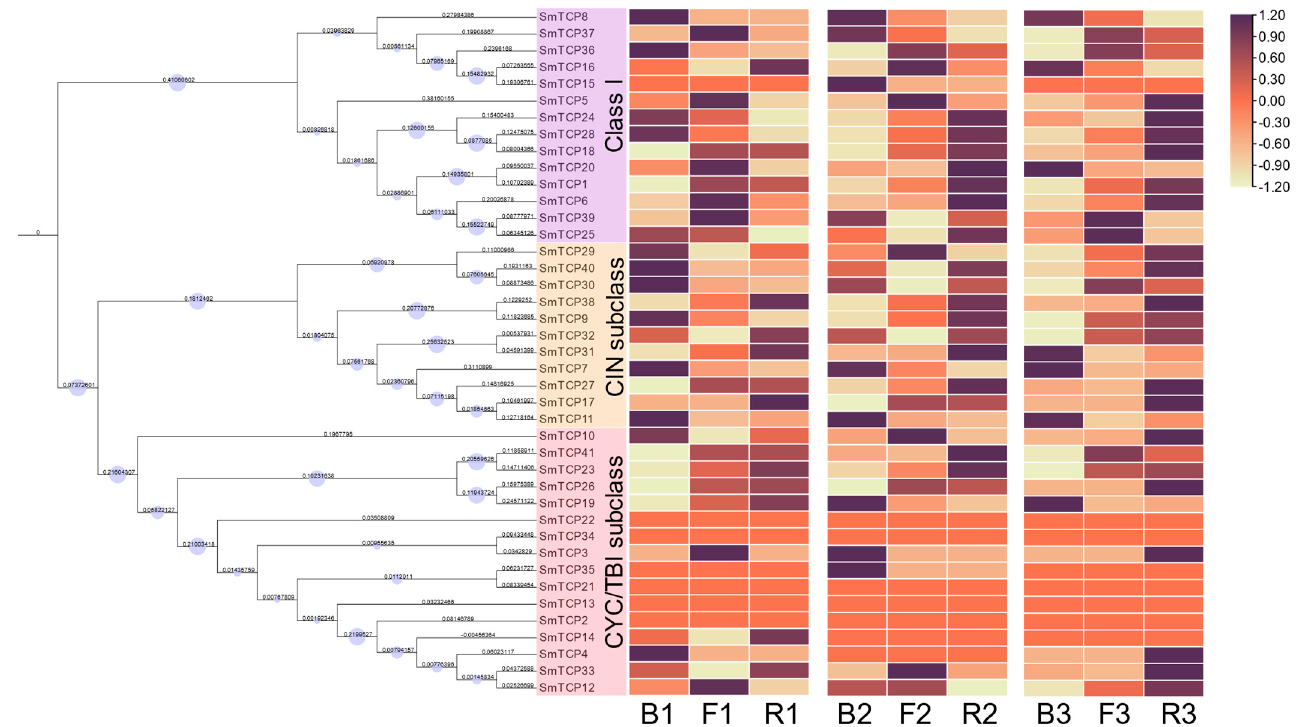
Figure 6. Heat map and hierarchical clustering of the SmTCP genes under each lighting treatment. Note: blue light (B), red light (R), full spectra (F) and three stages (B1–R1, B2–R2, and B3–R3).